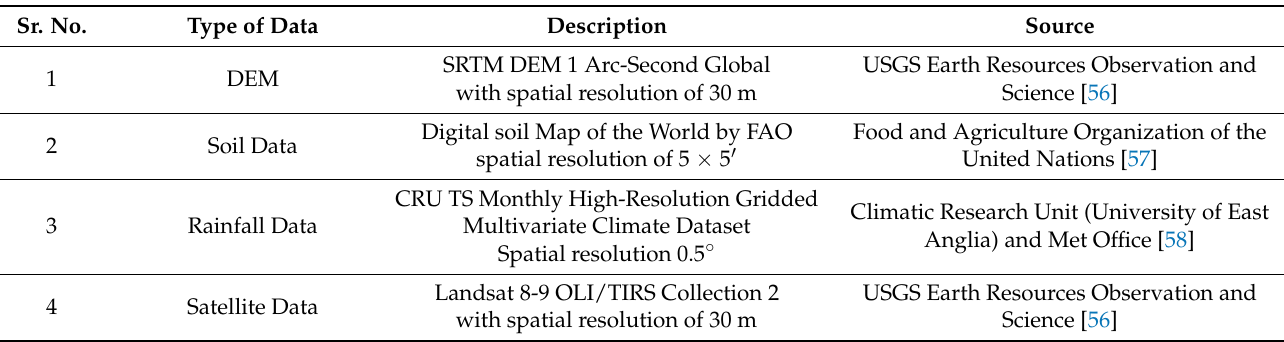
Table 1. Sources of remotely sensed data.